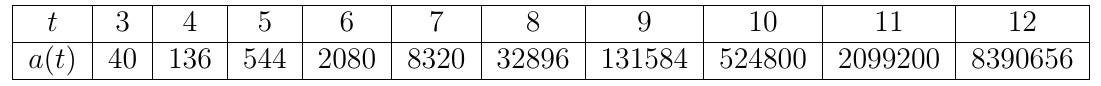
Table 1: Number of non-isomorphic trees formed by a chain of paths crossing with t copies of P